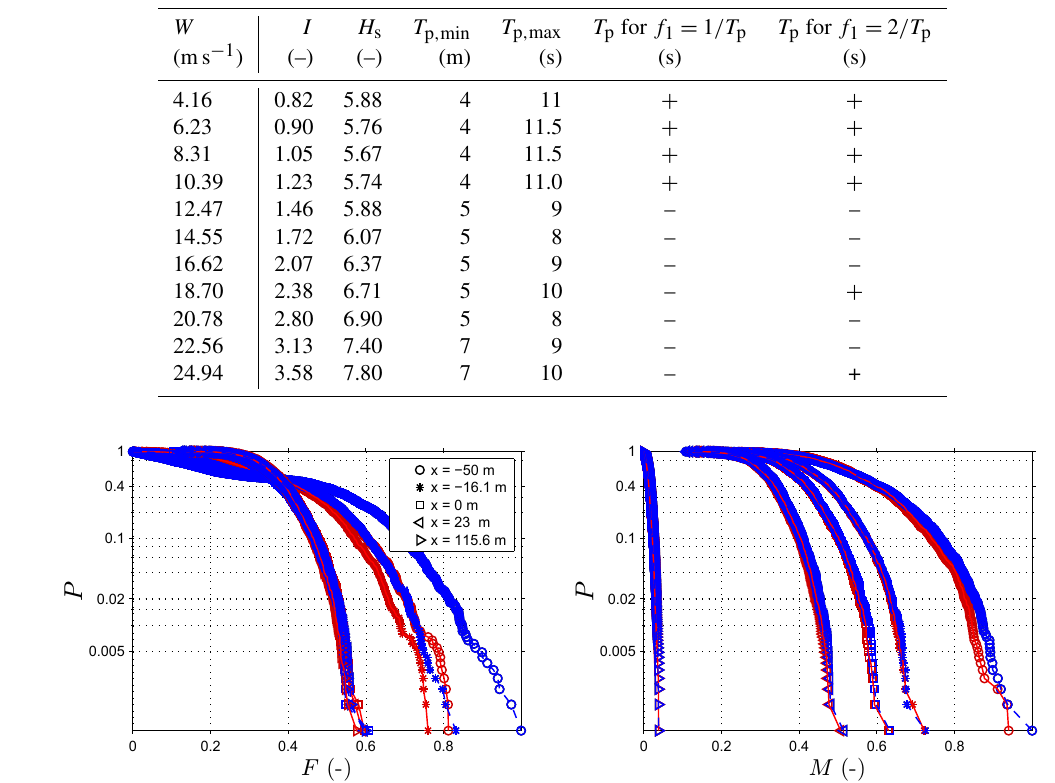
Table 2. The wind speeds and the turbulence intensity and sea states for load case 1.3.